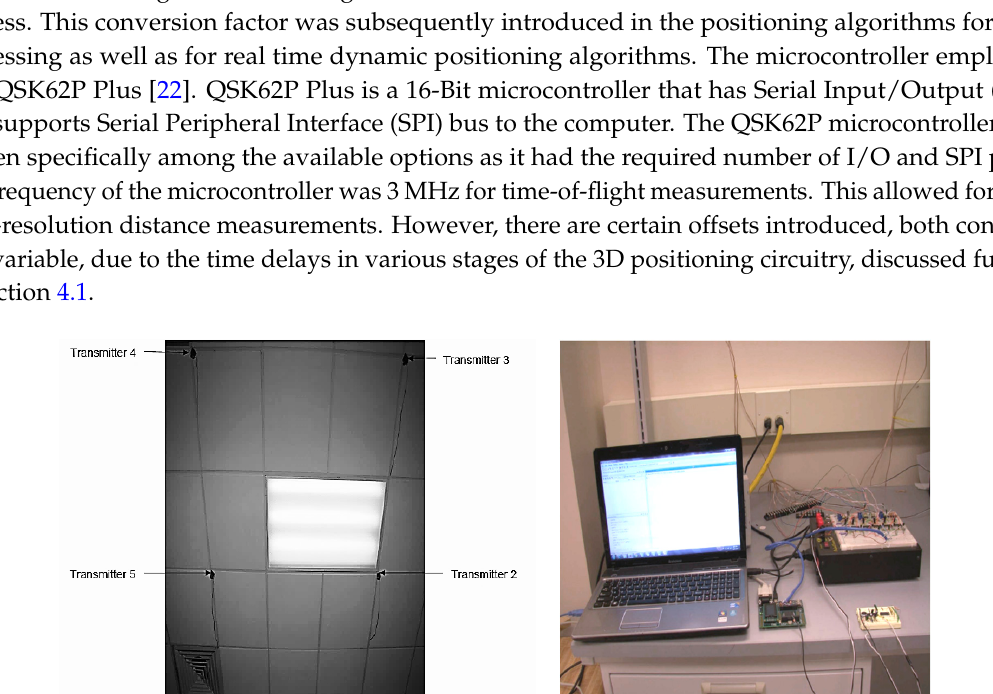
Figure 7. Layout of the experimental setup, consisting of: ( a ) transmitters mounted on the ceiling; ( b ) 3D positioning system.